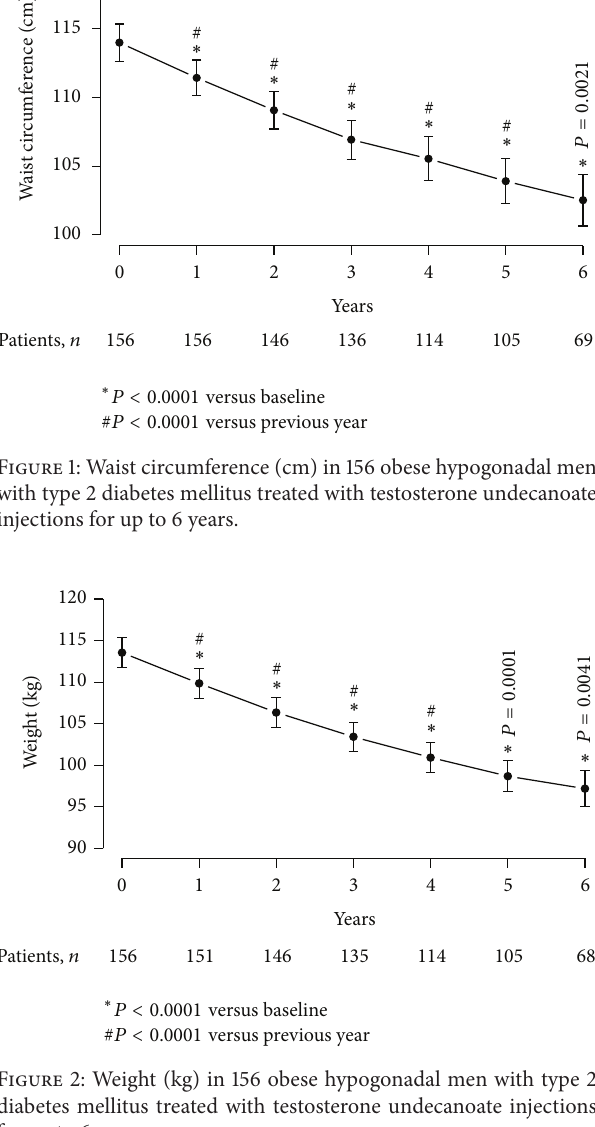
Table2:Comorbiditiesandconcomitantmedicationsatbaselinefor